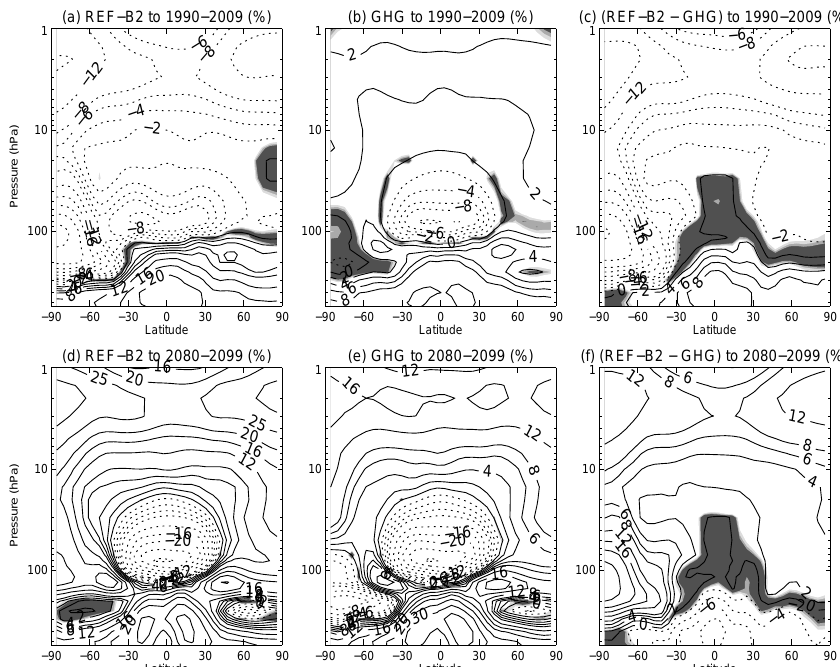
Fig. 2. The change in the zonal annual average ozone mixing ratio from 1960–1974 to 1990–2009 (top row) and the change from 1990–2009 to 2080–2099 (bottom row) for REF-B2, GHG and (REF-B2–GHG). All changes are expressed as percentages of the 1960–1974 average. Shading denotes regions where the differences are not statistically significant at the 98, 95 and 90% level as deduced from the student’s t-test accounting for lag-1 autocorrelation.